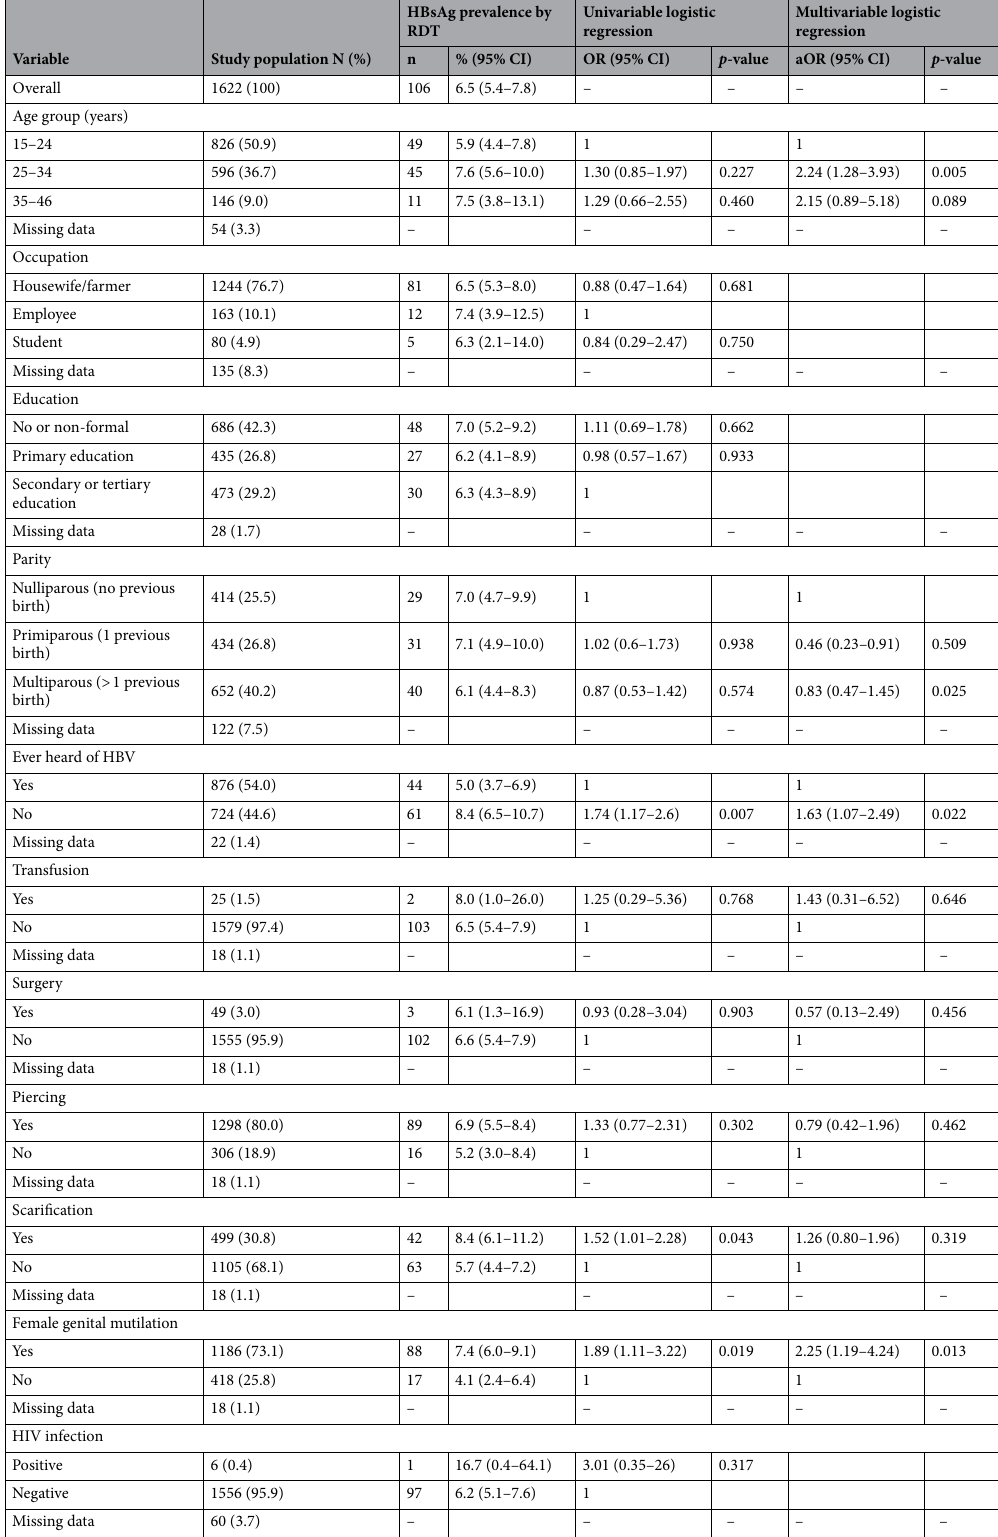
Table 1. HBsAg prevalence and logistic regression analysis of factors associated with HBsAg among pregnant women in Yako, rural Burkina Faso. Multivariable logistic regression by backward stepwise selection (probability of entry p < 0.25, probability of removal p < 0.3) with age group, transfusion, surgery, piercing, scarification, and female genital mutilation as forced variables. N = 1453; R 2 = 0.033; Model p = 0.008. HBsAg, Hepatitis B surface antigen; HBV, Hepatitis B virus; RDT, Rapid diagnostic test; OR, Odds ratio; aOR, Adjusted odds ratio; HIV, Human immunodeficiency virus; CI, confidence